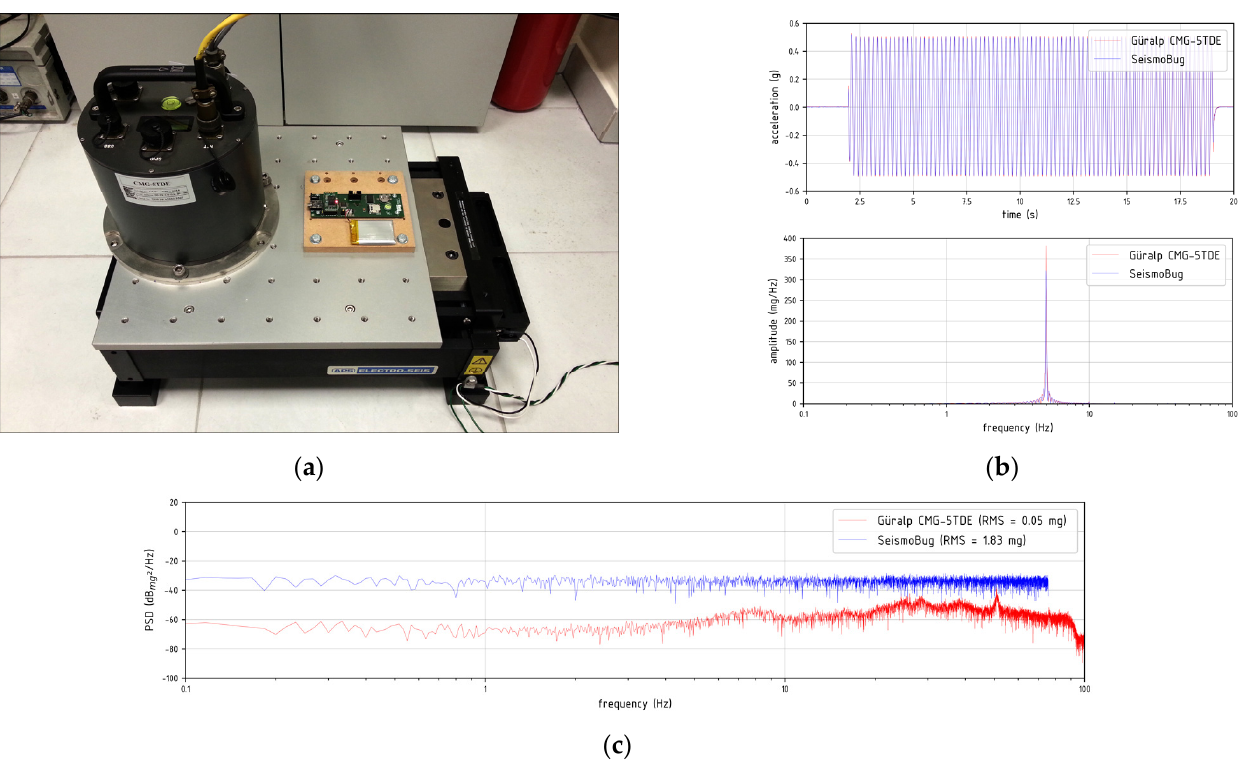
Figure 3. The SeismoBug © Monitor software: ( a ) device settings ( b ) triggering settings ( c ) data retrieval ( d ) real-time mode ( e ) postprocessing.